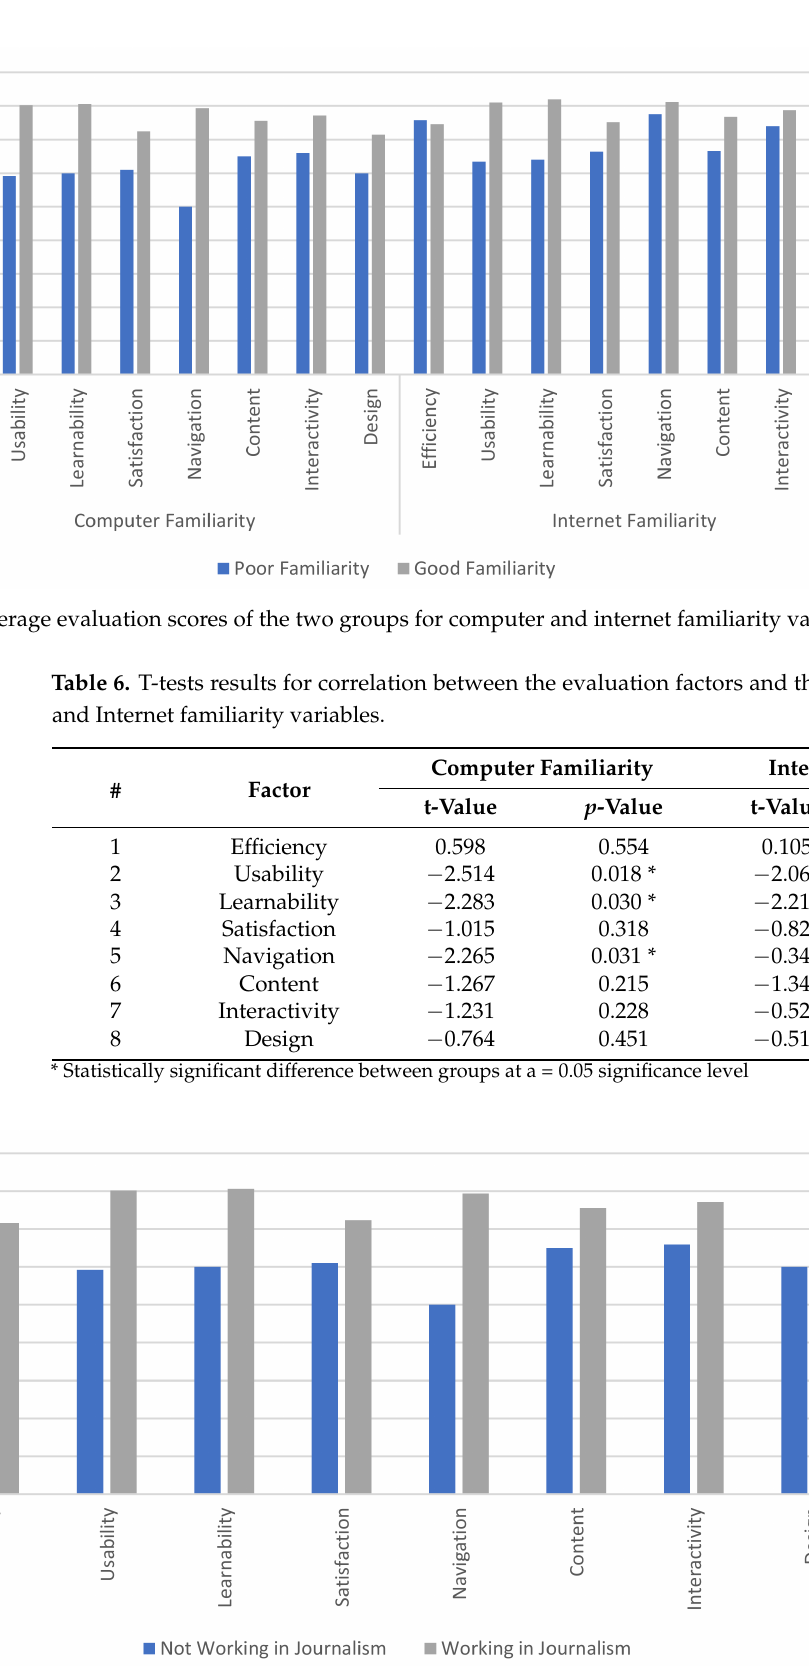
Figure 7. Average evaluation scores of groups in Journalism